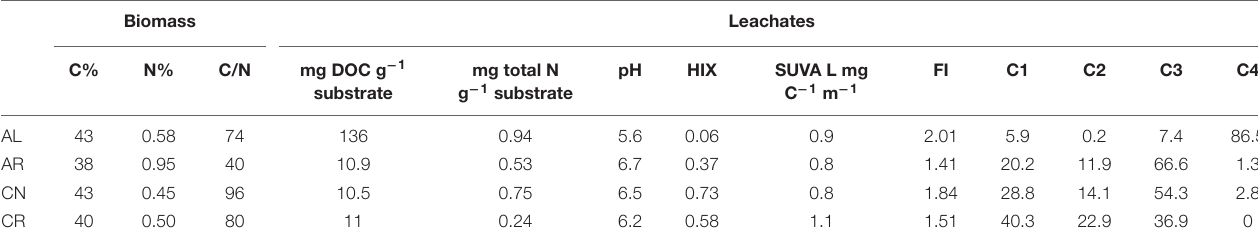
TABLE 2 | Selected properties of plant biomass and pre-sorption leachates derived from foliage and root biomass (C1–C4 are four components of the PARAFAC model and values are percentages of total fluorescence). Biomass